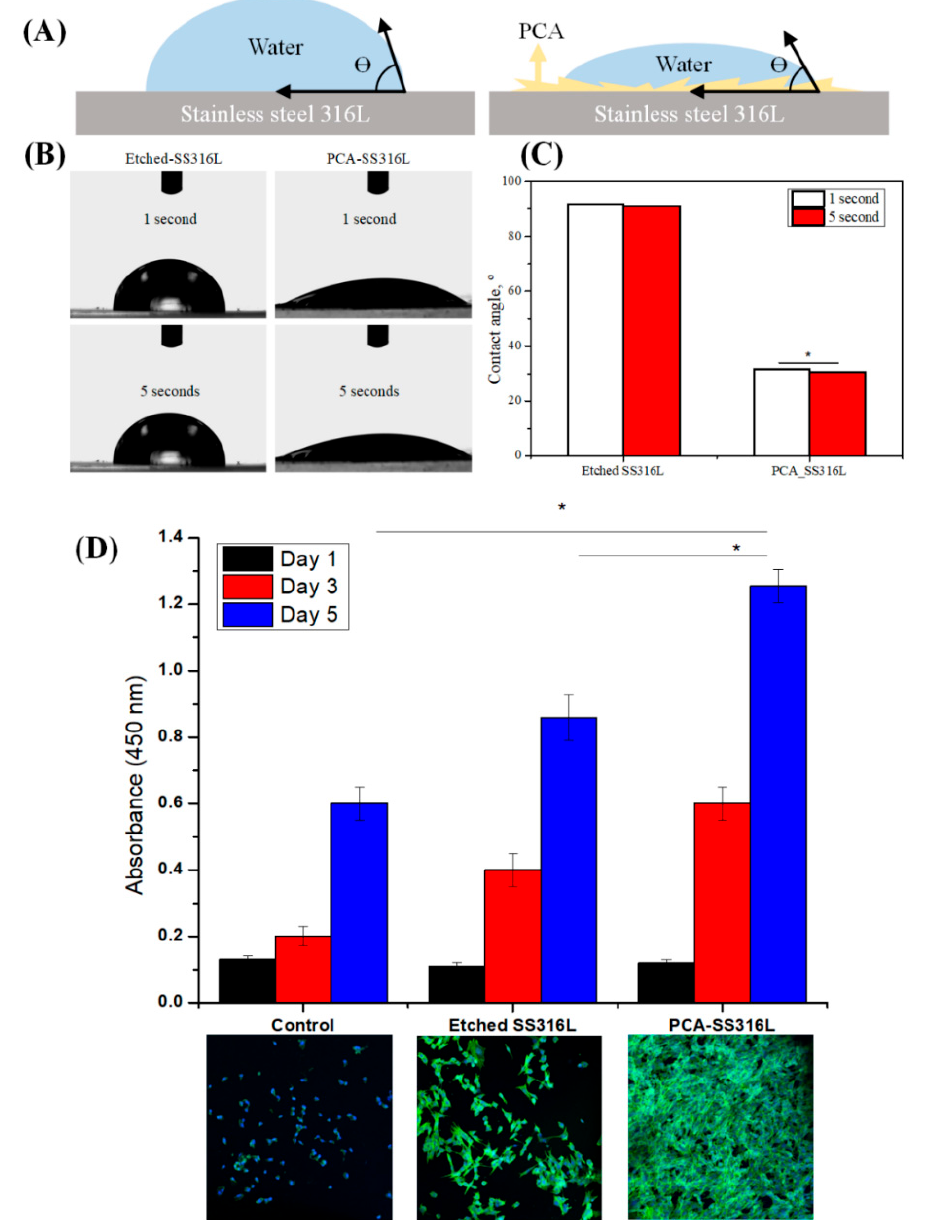
Figure 5. ( A ) Schematic showing a water droplet sitting on an etched stainless steel 316L substrate and a stainless steel 316L substrate covered by polycaffeic acid. ( B ) Optical images showing a macroscopic water droplet on an etched stainless steel 316L substrate and a stainless steel 316L substrate covered by polycaffeic acid at 1 and 5 s. ( C ) Comparison of the contact angle value of each substrate at 1 and 5 s, respectively. ( D ) NIH-3T3 cell proliferation on the control etched stainless steel 316L and stainless steel 316L covered with polycaffeic acid for 1, 3, and 5 days as measured by a CCK-8 assay. Inset: Confocal images showing the morphology of NIH-3T3 cells of substrates on different coatings after 5 days. Data are presented as the mean ± SD (n =